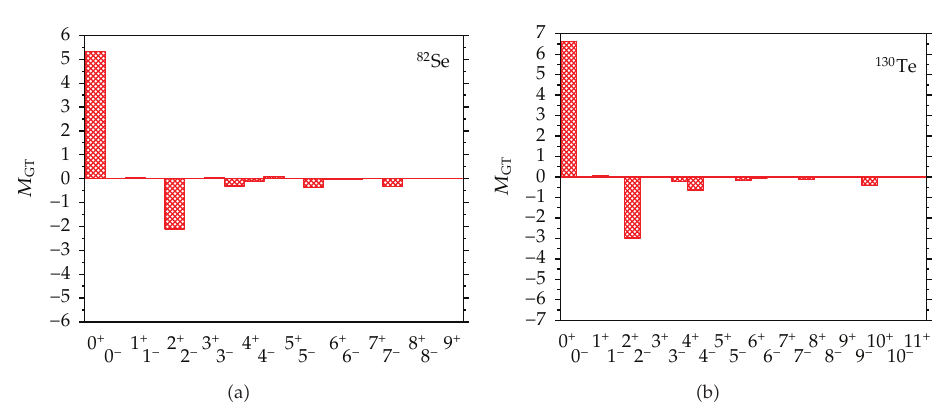
Figure 3: (cid:2) Color online (cid:3) Contributions to the Gamow-Teller matrix element of the 82 Se → 82 Kr and 130 Te → 130 Xe decays as a function of the J π of the transformed pair.